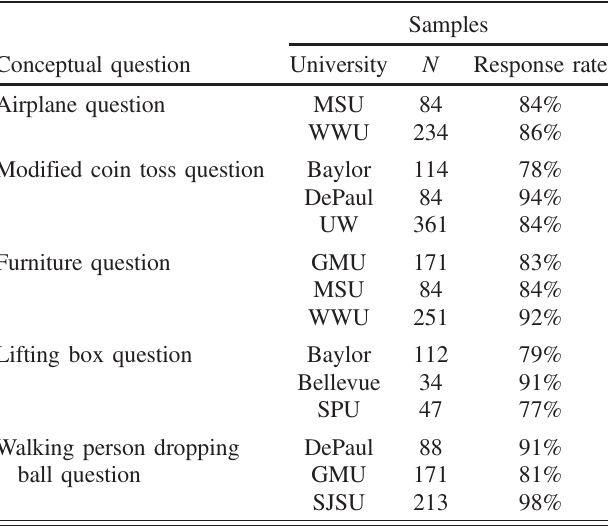
TABLE I. Study samples, by question.